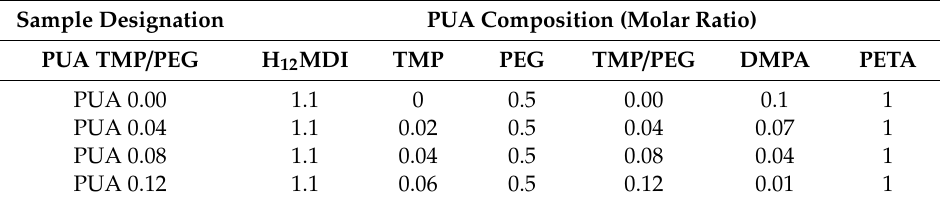
Figure 1. Schematic of the ( a ) chemical components and ( b ) preparation of a double-crosslinked polyurethane acrylate (PUA) membrane. Table 1. Sample designation and polyurethane acrylate (PUA) membrane composition.